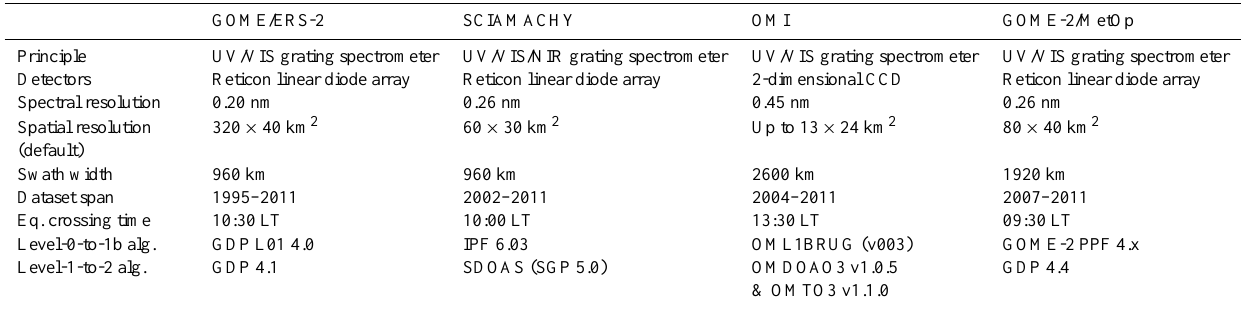
Table 1. Main characteristics of the GOME-2/MetOp GOME/ERS-2, SCIAMACHY and OMI instruments relevant to the total ozone column